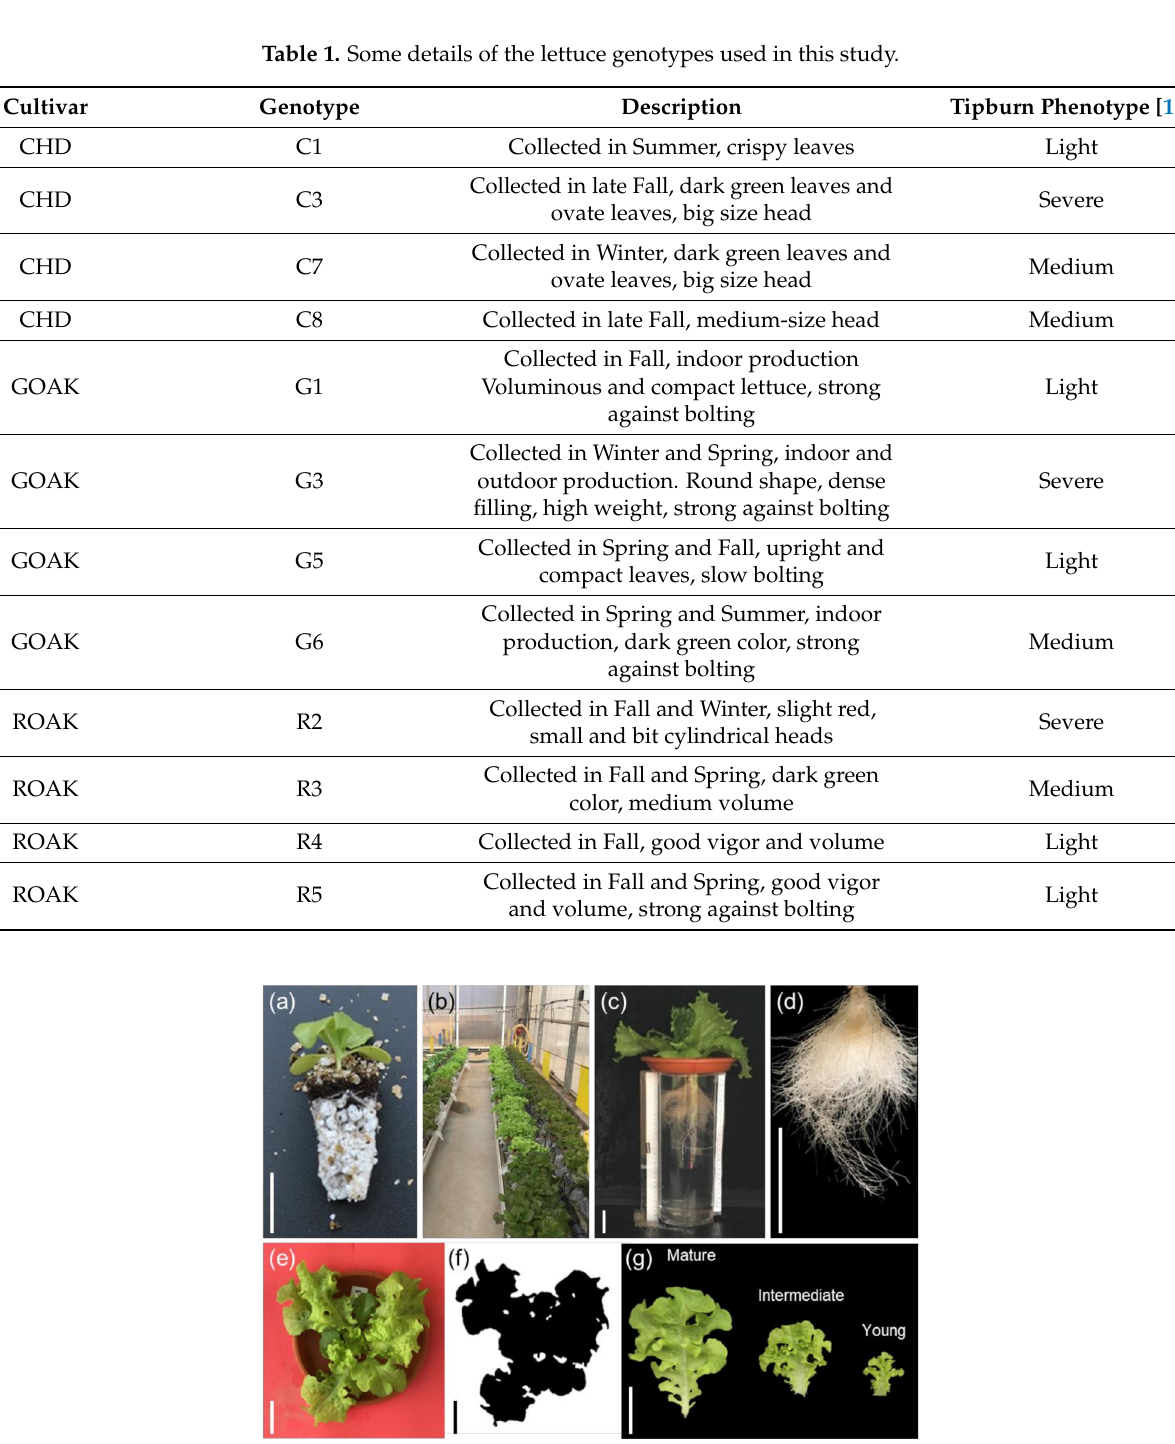
Figure 1. Experimental design for studying growth, tipburn phenotypes, and nutrient concentrations in different lettuce genotypes. ( a ) A representative image of a young seedling from the nursery chamber. ( b ) General view of the hydroponic system used for lettuce cultivation at the experimental station. ( c ) Glass cylinder vase used for image acquisition. ( d , e ) A representative image of the roots ( d ) and the shoot ( e ) of a plant grown in hydroponics for 21 days. ( f ) Image segmentation files obtained with Image J software. ( g ) A representative image of leaves collected for nutrient concentration analysis. Scale bars: 50